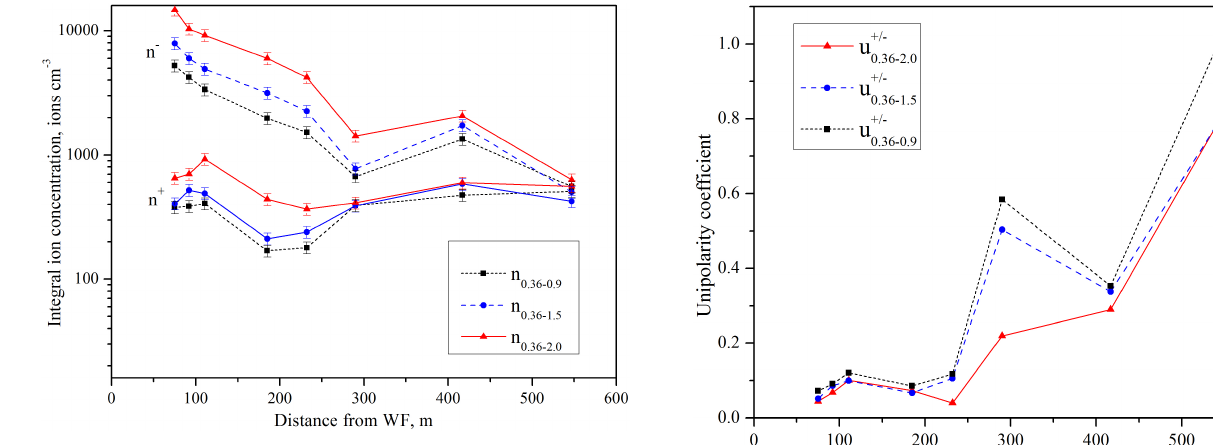
Fig. 7. Integral ion concentration distribution by ion boundary di- ameter and polarity versus distance, measured at the Krimml WF, orographic right side. Fig. 8. Unipolarity coefficients ( u